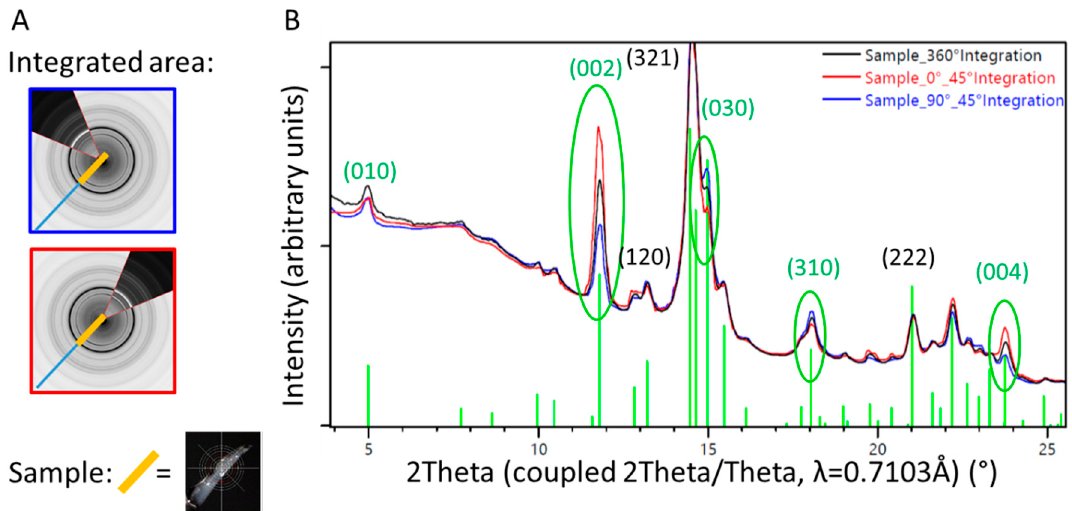
Figure 9. 1D diffraction pattern of a sample of trabecular bone from the surface of the retrieved stem. Diffraction patterns from specific sectors (blue and red lines, corresponding to the orientation of the detector illustrated on the left) are compared with results from the 360 ◦ integration (black line). The orientation of the HA within the ongrown bone is directional, which can be visualized by di ff erent intensity profiles in dependence of the direction of investigation, di ff ering from the random orientation observed in the 360 ◦ integration (black line). ( A ) Illustration of the partial integration of the 2D X-ray di ff raction profile, blue perpendicular to the sample orientation, and red parallel to the sample orientation. ( B ) 1D di ff raction profile superposed for the 360 ◦ (black) and 45 ◦ integration of the sectors illustrated in ( A